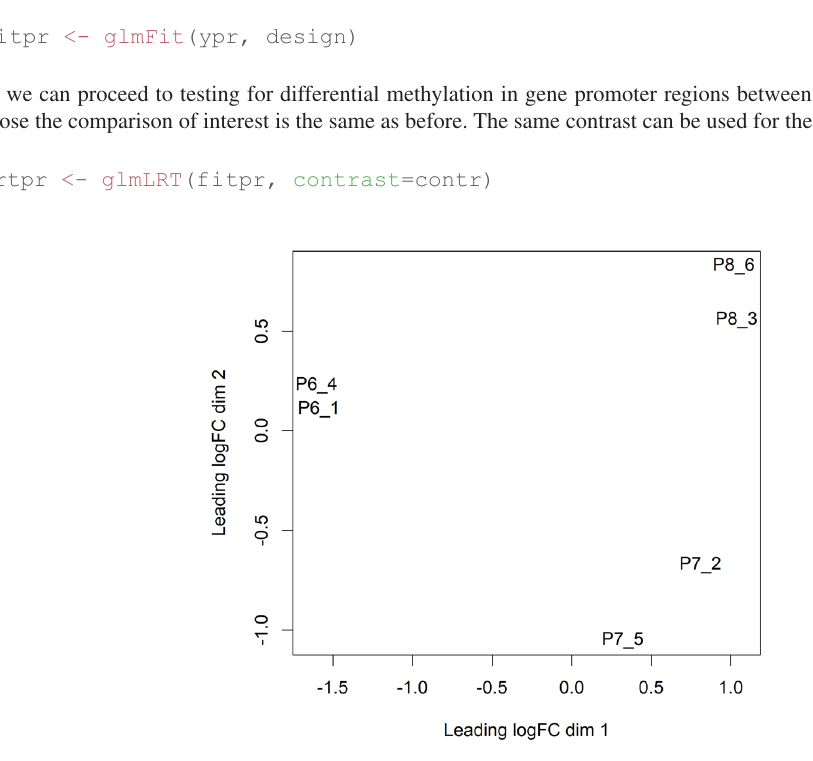
Figure 5. MDS plot showing differences in methylation profiles at gene promoters. Basal and luminal cell populations are well separated by the first